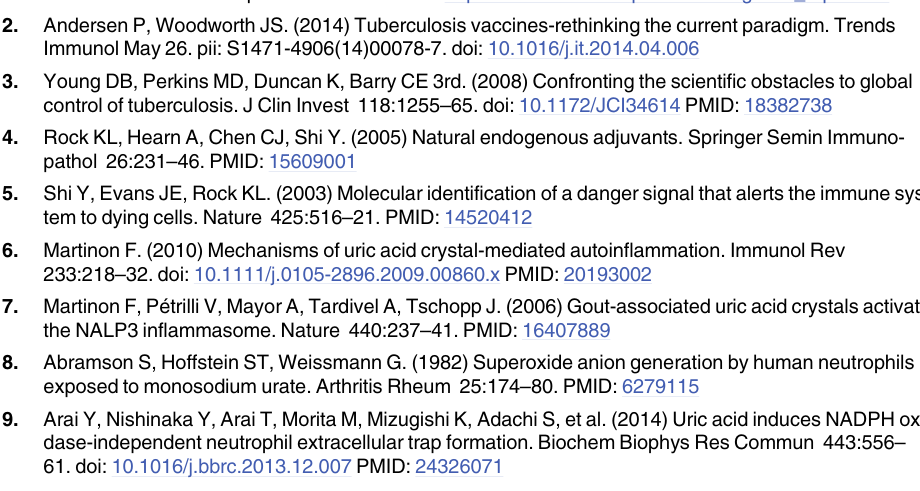
S1 Fig. PEG-catalase pre-treatment reduces ROS levels induced by MSU. dTHP-1 cells were labeled with 10 μ M DCF for 60 min. Thereafter, cells were washed twice, stimulated for 20 minutes with 5 μ g/ml MSU in the presence or absence of 100 U/ml PEG-catalase (Cat). Results are expressed as means ± SD of arbitrary fluorescence units of triplicates and are representative of two independent experiments. (cid:5) p < 0.05 in comparison with non stimulated control cells,